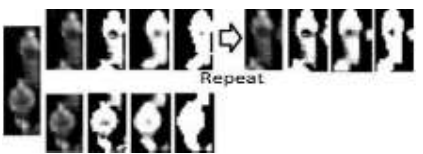
Figure 25. Locating pedestrian in middle of box and transforming box center into weight center points.